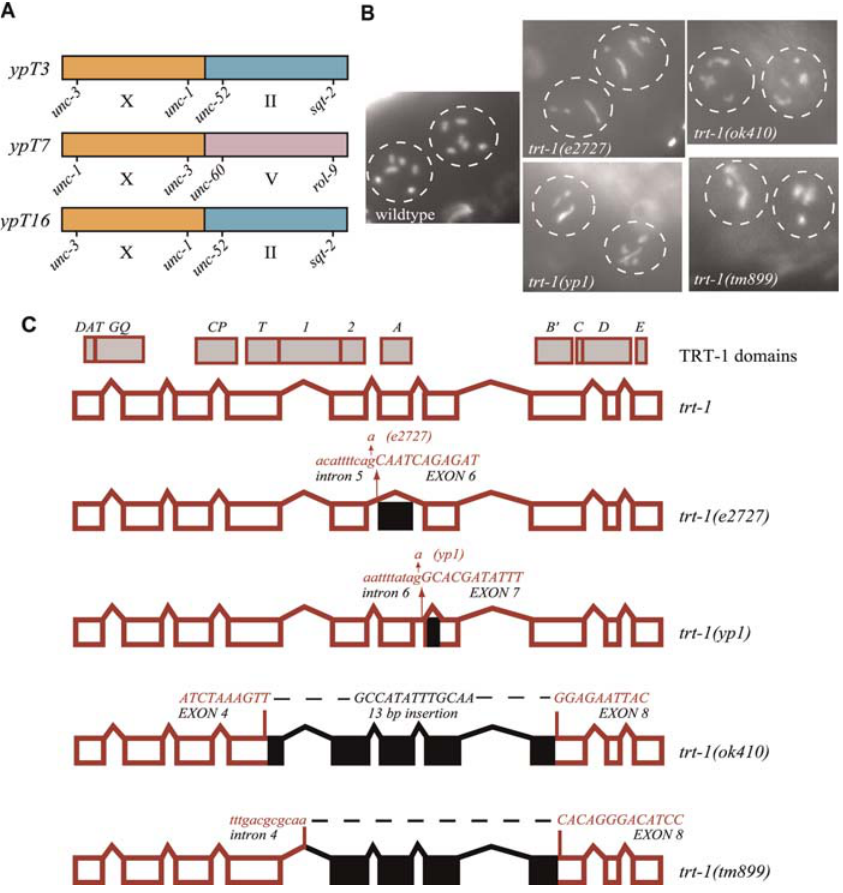
Figure 1. trt-1 Is the C. elegans Catalytic Subunit of Telomerase (A) Three X-autosome fusions isolated from trt-1(e2727) display linkage between an end of the X chromosome and an end of an autosome. ypT3 and ypT16 were independent chromosome fusions isolated from parallel lines grown from the same F2 founder, suggesting that the two fusiogenic chromosome ends may correspond to short telomeres in the F2 founder, recapitulating our previous observations regarding strains inheriting a short left end of the X chromosome in mrt-2 mutants [12] and supporting a mouse study of telomere length and genome instability in the absence of the telomerase RNA [61]. (B) End-to-end fusions in oocytes of late-generation trt-1 mutant worms. Two DAPI-stained oocyte nuclei are shown per picture as indicated by dashed circles. (C) trt-1 gene structure with mutations. Exon-intron structures and TERT protein domains are shown. Effects of mutations for all four trt-1 alleles are shown as determined by genomic DNA and cDNA sequencing. Black boxes are used to depict exons missing as a consequence of trt-1 splice-junction mutations or sequences eliminated by trt-1 deletions. For yp1, intron 6 is retained and a cryptic intron in exon 7 becomes active. Sequences flanking each breakpoint are shown for trt-1 deletions. A 13-bp in-frame insertion occurred at the breakpoint of trt-1(ok410) . Sequencing of cDNA from trt- 1(tm899) indicated that the deletion results in a premature stop codon. DOI: